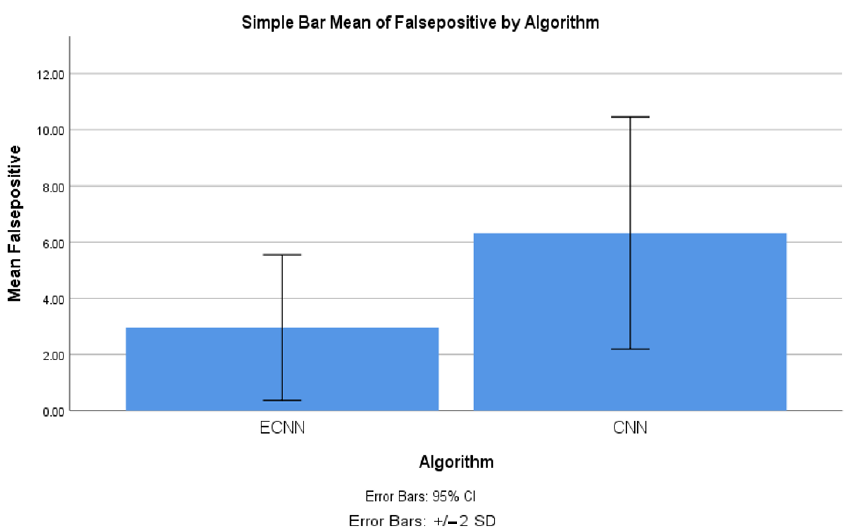
Figure 9. Mean false-positive comparison between ECNN and CNN with confidence interval 95% and standard deviation ±2 .